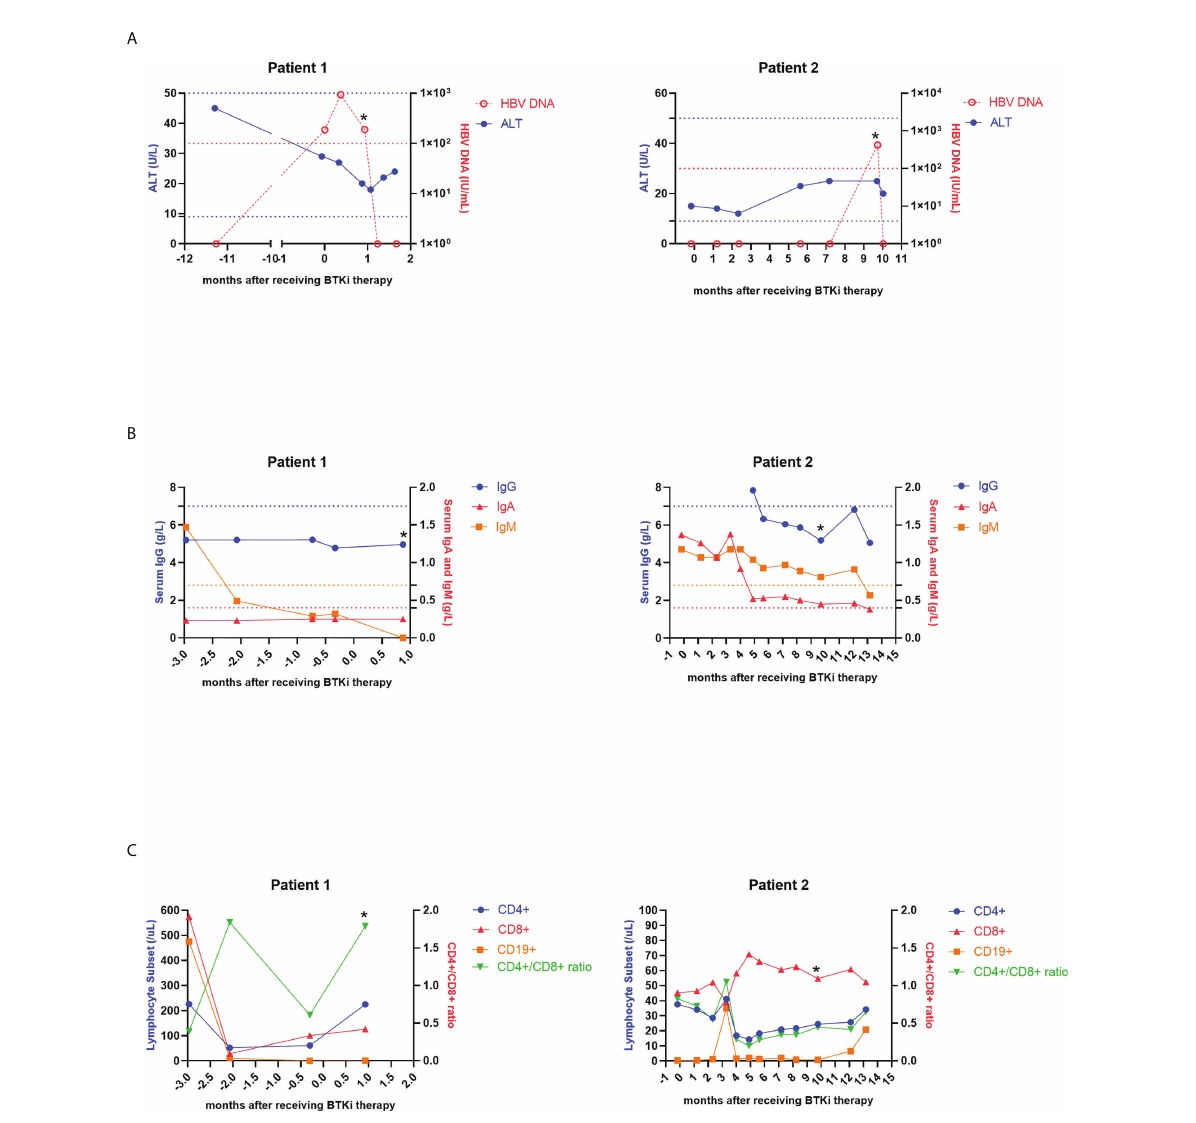
FIGURE 2 Dynamic changes of ALT, HBV DNA copies (A) , serum levels of IgG, IgA, IgM (B) and lymphocyte subsets (C) in two patients with HBVr. An asterisk (*) indicates HBVr. ALT, alanine aminotransferase; HBV, hepatitis B virus; BTKi, Bruton Tyrosine Kinase inhibitor; Ig, immunoglobulin; HBVr, hepatitis B virus